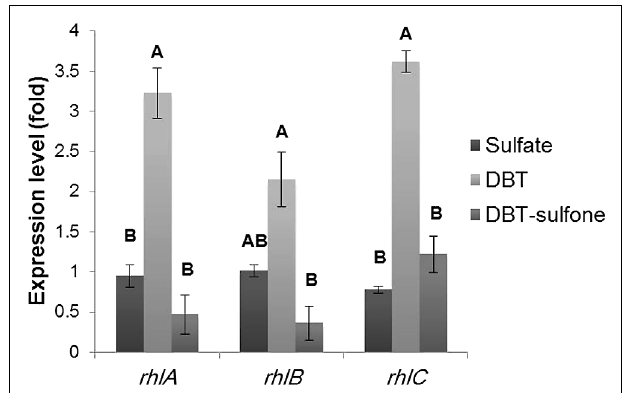
FIGURE 6 | Results of RT-qPCR showing the relative expression levels of the rhlABC genes inAK6U cultures grown with different sulfur sources in the presence of glucose as a carbon source. The expression level was calculated relative to that of the MgSO 4 culture as a control group. Data are means of at least two replicates ± SE. Significantly different values ( p < 0.05) are indicated by different letters above the bars.